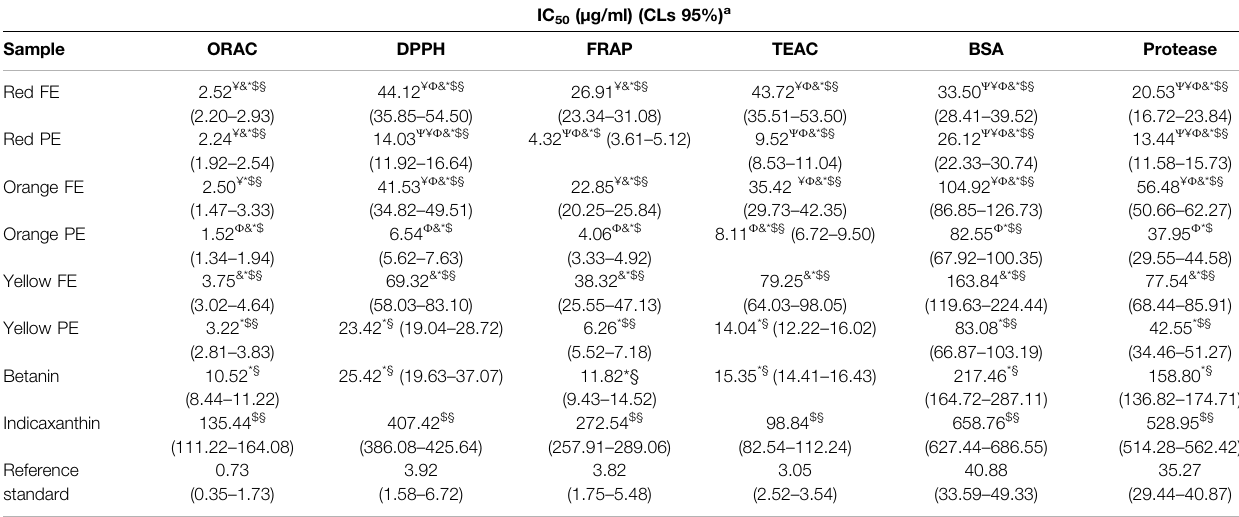
TABLE2| Antioxidantandanti-in fl ammatoryactivitiesofpricklypear fl eshandpeelextracts(FEsandPEs,respectively)incomparisonwiththeirmostabundantcompounds (betanin and indicaxanthin) and the reference standard (trolox and diclofenac sodium for antioxidant and anti-in fl ammatory activities,